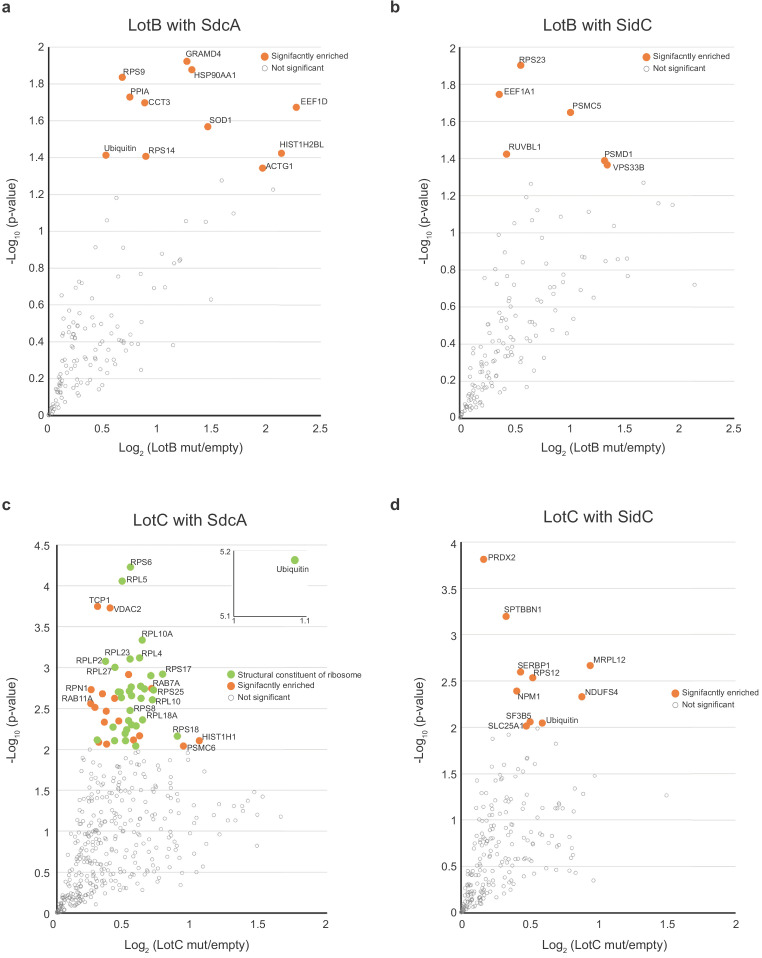
Proteomic analysis of interacting partners of LotB and LotC together with Legionella E3s.(a, b) Proteomic analysis of interacting partners of LotB together with SdcA and SidC, respectively. Catalytically inactive FLAG-LotB (C29A) was co-transfected with either SdcA or SidC and immunoprecipitated. Co-precipitated interacting proteins were analyzed by mass spectrometry. (c, d) Proteomic analysis of interacting partners of LotC together with SdcA and SidC, respectively. Catalytically inactive FLAG-LotC (C24A) was co-transfected with either SdcA or SidC and immunoprecipitated. Co-precipitated interacting proteins were analyzed by mass spectrometry.Figure 5—figure supplement 2—source data 1.Mass spectrometry data used in Figure 5—figure supplement 2a, b.Figure 5—figure supplement 2—source data 2.Mass spectrometry data used in Figure 5—figure supplement 2c, d.